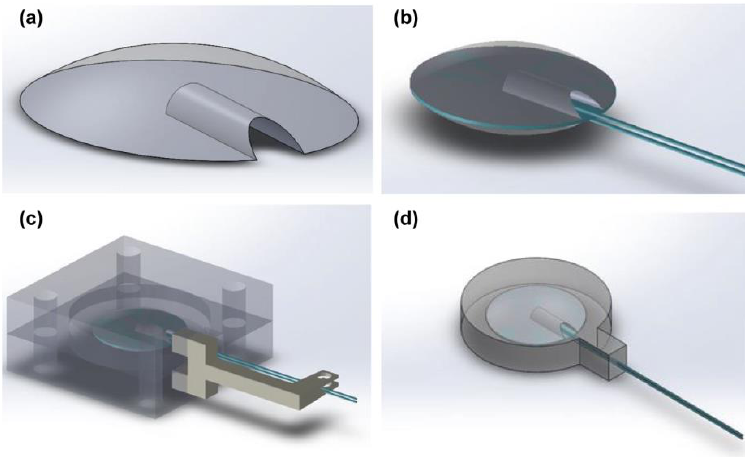
Figure 1. Encapsulated transducer for haptic applications. ( a ) Upper view of one of the spherical cups; ( b ) Encapsulated transducer with the two spherical cups on the opposite sides and the embedded electrical contacts; ( c ) 3D-printed customized mold for the development of the geometry of the transducer with PDMS polymer. The piezoelectric element with the spherical cups and the electrical connections are located at the center of the molding stucture; and ( d ) an upper view of the transducer, with evidence of the internal structure where two spherical cups enclose the piezoelectric disk and the electrical wires.